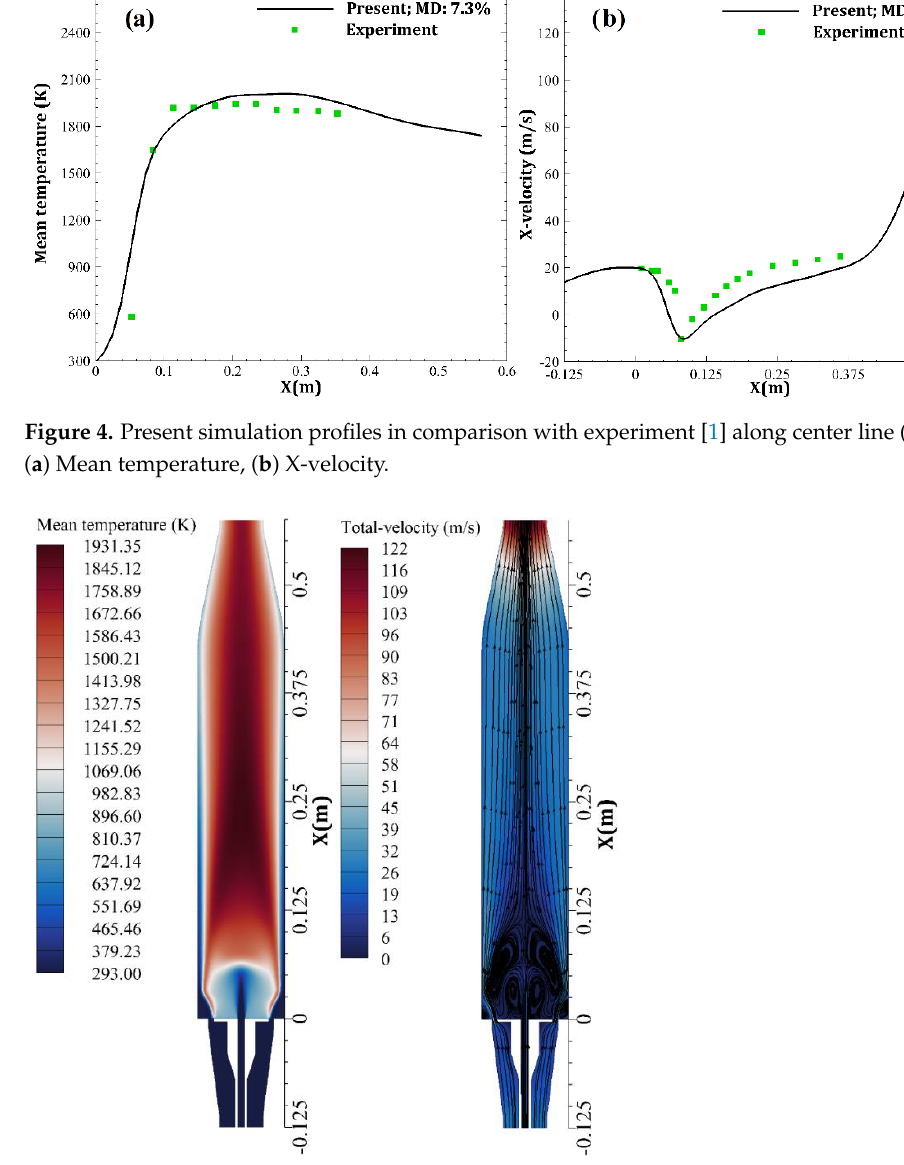
Figure 5. Contours of mean temperature and velocity (mid-plane, Z = 0).